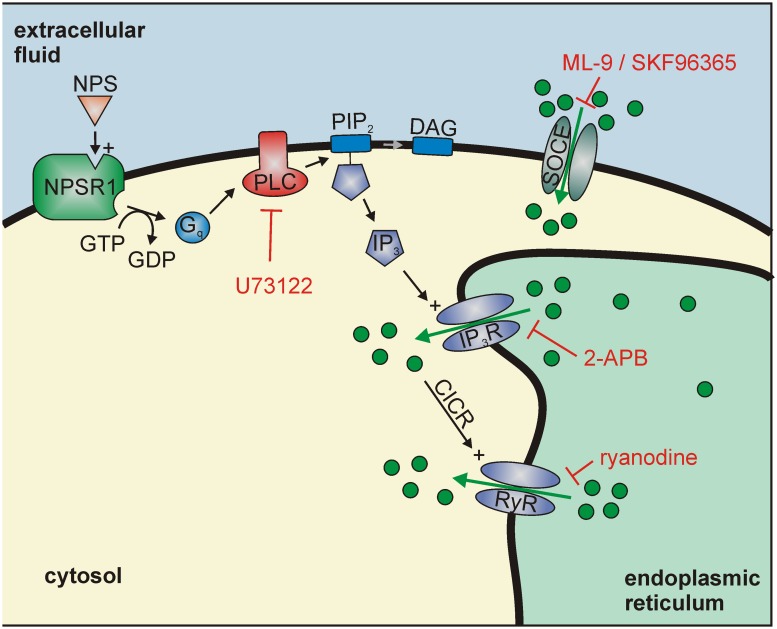
Model for the intracellular mechanisms underlying NPSR1 activation in cultured mouse hippocampus neurons.Calcium is released from the endoplasmic reticulum via IP3 and ryanodine receptors, which can be blocked by U73122, 2-APB and ryanodine, respectively. This decrease in the ER calcium content activates store-operated calcium entry (SOCE), which can be visualized by using Ca2+-free extracellular solution, the underlying signal cascade can be blocked by ML-9 and SKF96365.